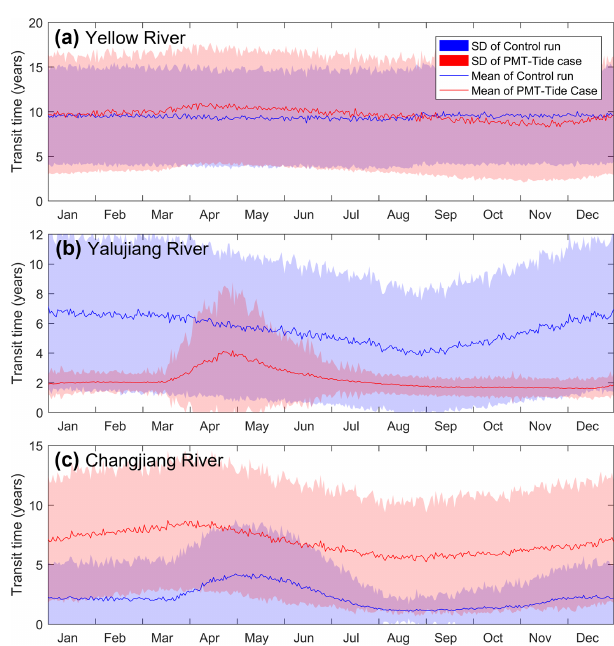
Figure 13. The daily mean water transit time over the shelf of the three rivers for the control run (blue) and PMT–tide case (red). SD in the figure label denotes the standard deviation of the transit time for particles released on the same